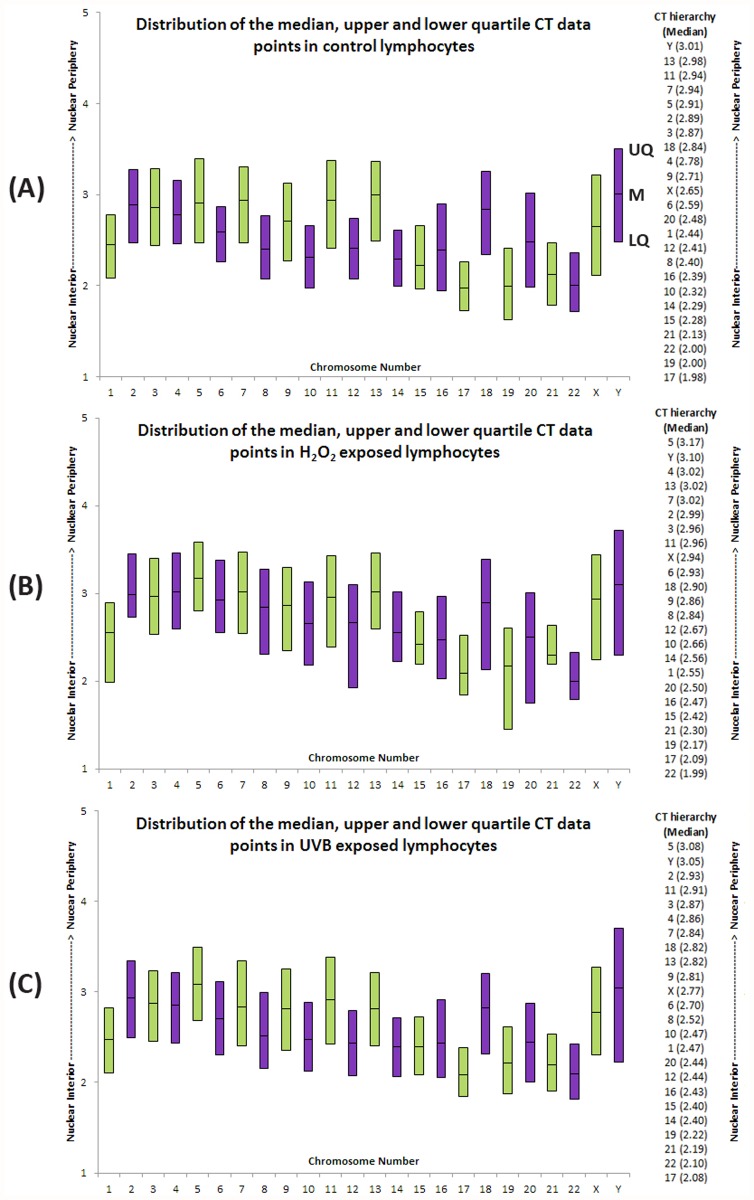
Hierarchical organization of all 24 human chromosomes and distribution of the median, upper and lower quartile CT data points in control H2O2 and UVB exposed lymphocytes.Box-plot representation of the distribution of all 24 chromosomes within lymphocytes in all six subjects. Panels A, B and C depict the distribution in control, H2O2, and UVB exposed lymphocytes, respectively. Each histographic bar represents the upper quartile, median, and lower quartile for each CT position from the nuclear interior to the nuclear periphery (Y axis). Panel A, displays the points that correspond to the upper quartile (UQ), median (M) and lower quartile (LQ) on the Y chromosome. Odd numbered chromosomes and chromosome X are represented by green bars, whereas even chromosomes and chromosome Y are represented by purple bars. The column of numbers to the right of the box-plot displays the hierarchical organization of CTs determined from the median CT data for the corresponding exposure conditions. The column of CTs are ordered from the nuclear interior (bottom) toward the nuclear periphery (top). Numbers in parentheses represents the mean median value for each CT (lower median values indicate closer proximity to the nuclear interior). Note, data for all CTs is based on measurements taken in 600 cells (n = 6) with the exception of the Y chromosome, which is obtained from 200 data points (n = 2).